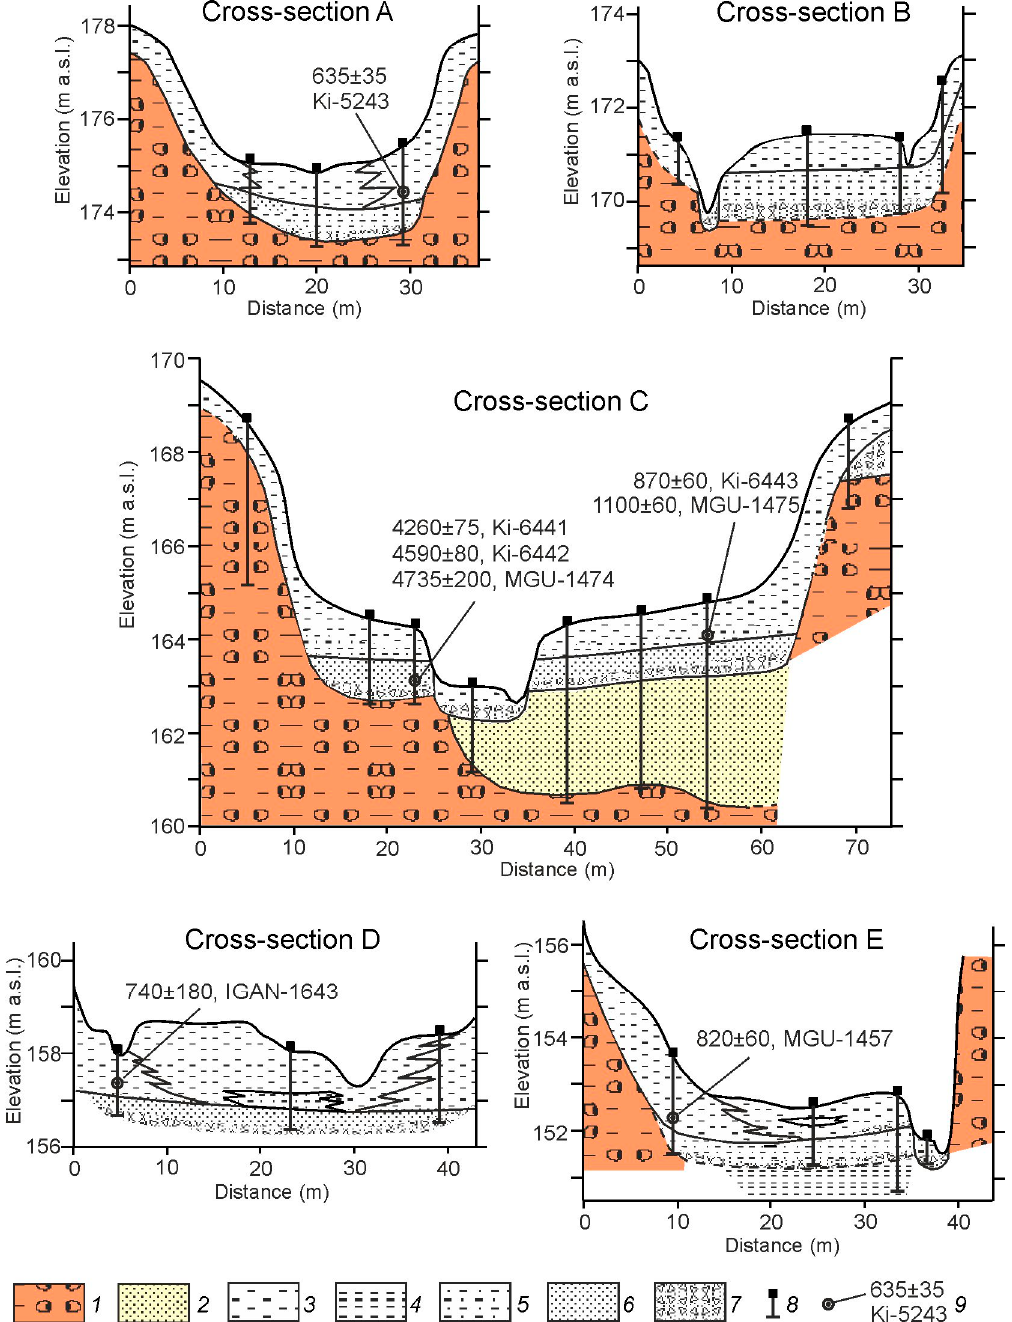
Figure 10. Cross-sections of the Yazvitsa Balka. Keys: 1—till, 2—glaciofluvial sand, 3—loam. 4—silt, 5—sandy loam, 6—sand, 7—gravel, 8—pits and cores, 9— 14 C samples and dates.